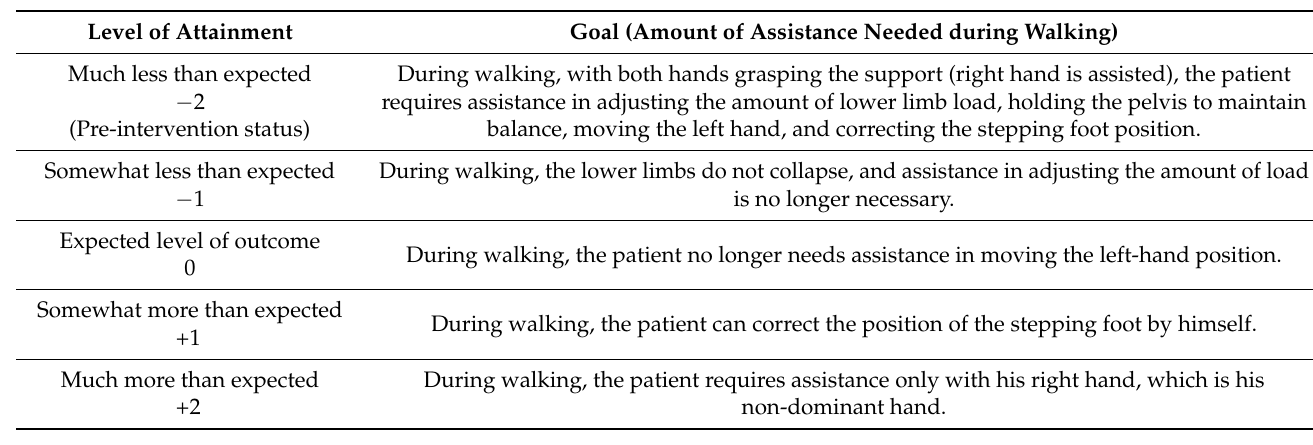
Table 1. Goal setting in this case using the goal attainment scaling